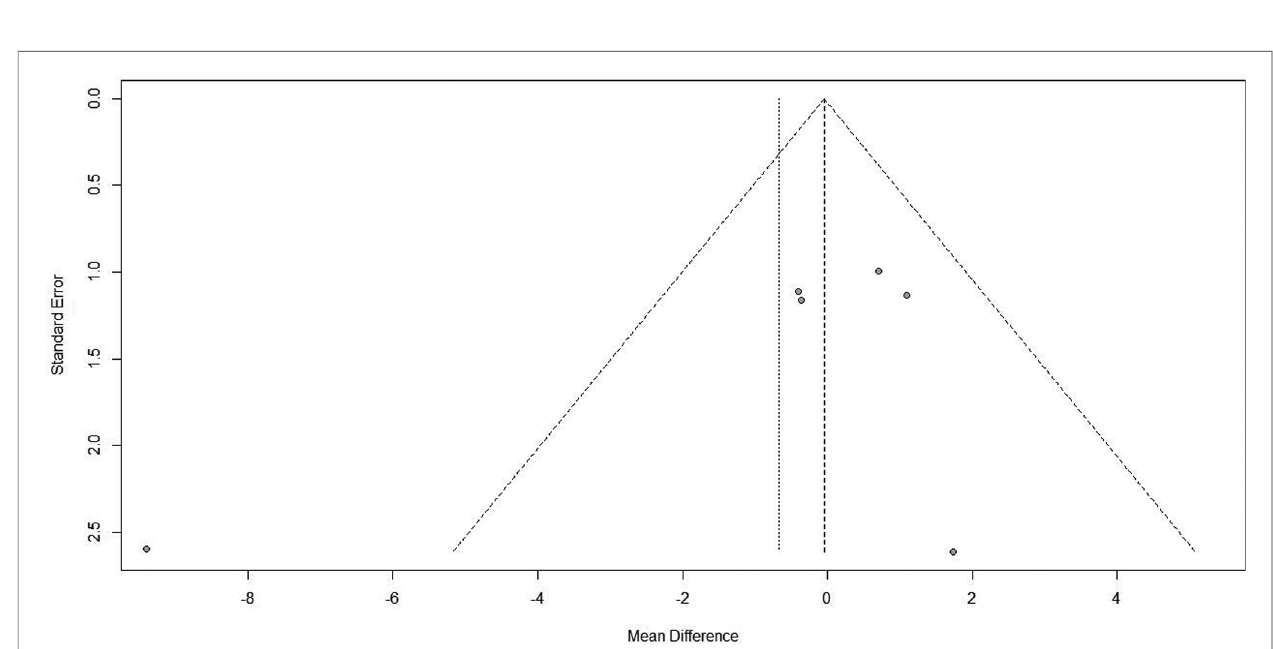
FIGURE 7 | Comparison of cesarean section rate after blood glucose control during pregnancy.